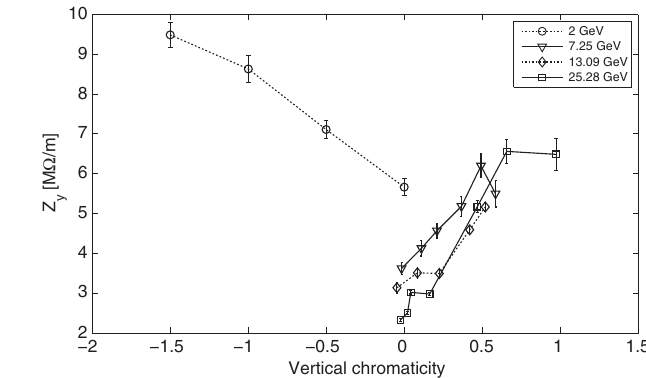
FIG. 12. Horizontal and vertical total PS impedance model (sum of dipolar and quadrupolar components) a 2 GeV. The curves are obtained summing the contributions of space charge, resistive wall, kickers, rf, and vacuum equipments.